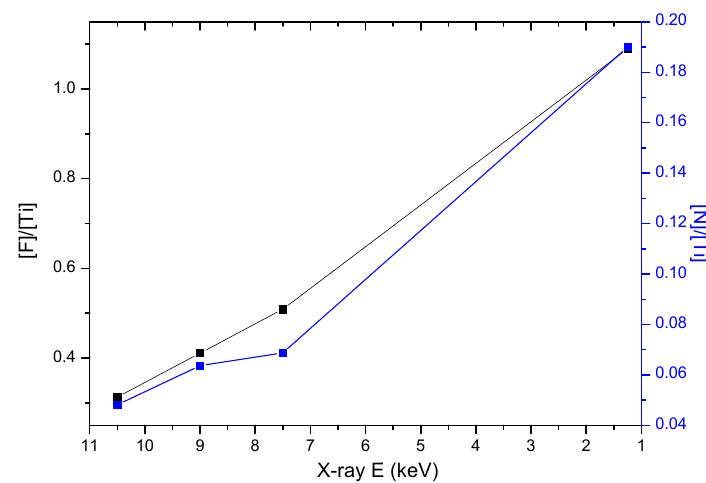
Figure 9. Evolution of [N] / [Ti] for APhTS / TIPT (right) and [F] / [Ti] for PFDS / TIPT (left) as a function of x-ray beam energy. Note inclusion of additional data from conventional XPS analysis.